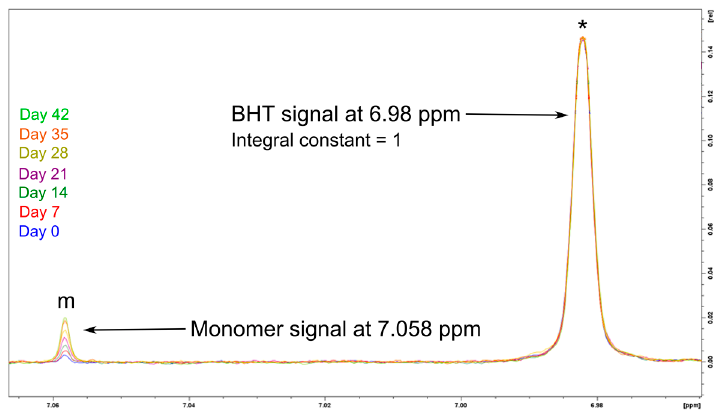
Figure 9. The 1 H NMR spectrum section of the monomer (m) and BHT (*) signal in 2000 g/mol PBCA stored for seven weeks as solution in CDCl 3 . The BHT signal area (*) was constant during the storage, and consequently the integral value for BHT was assumed to be 1.